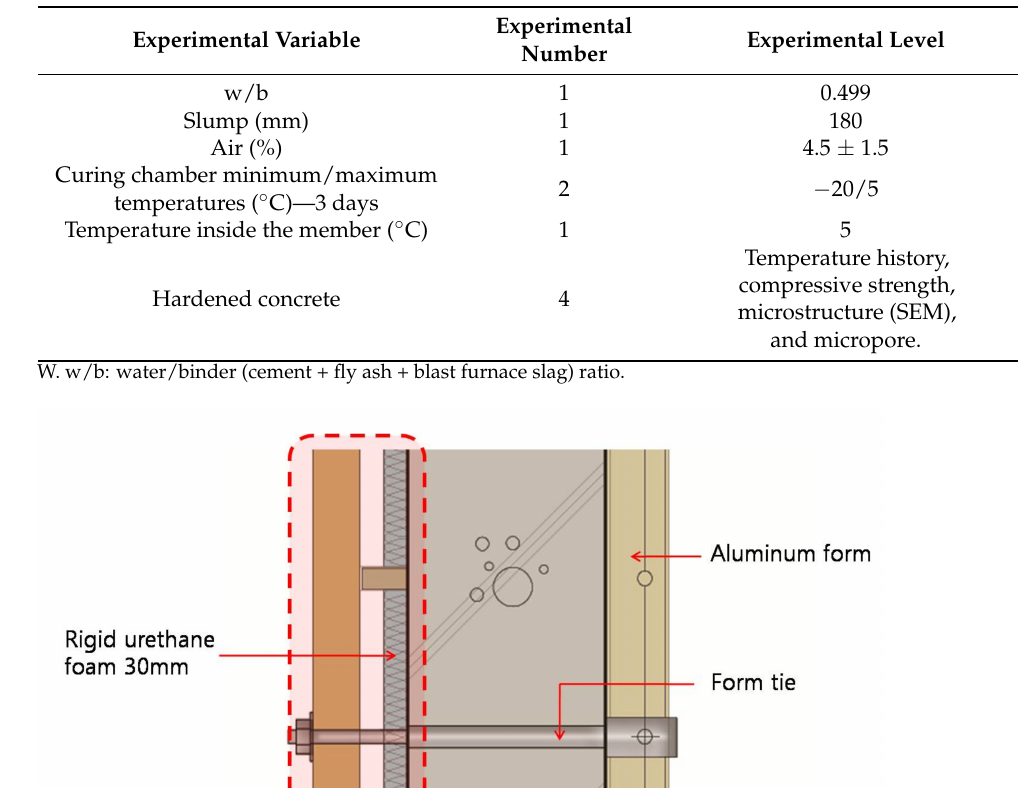
Table 1. Experimental design: variables, number, and level.